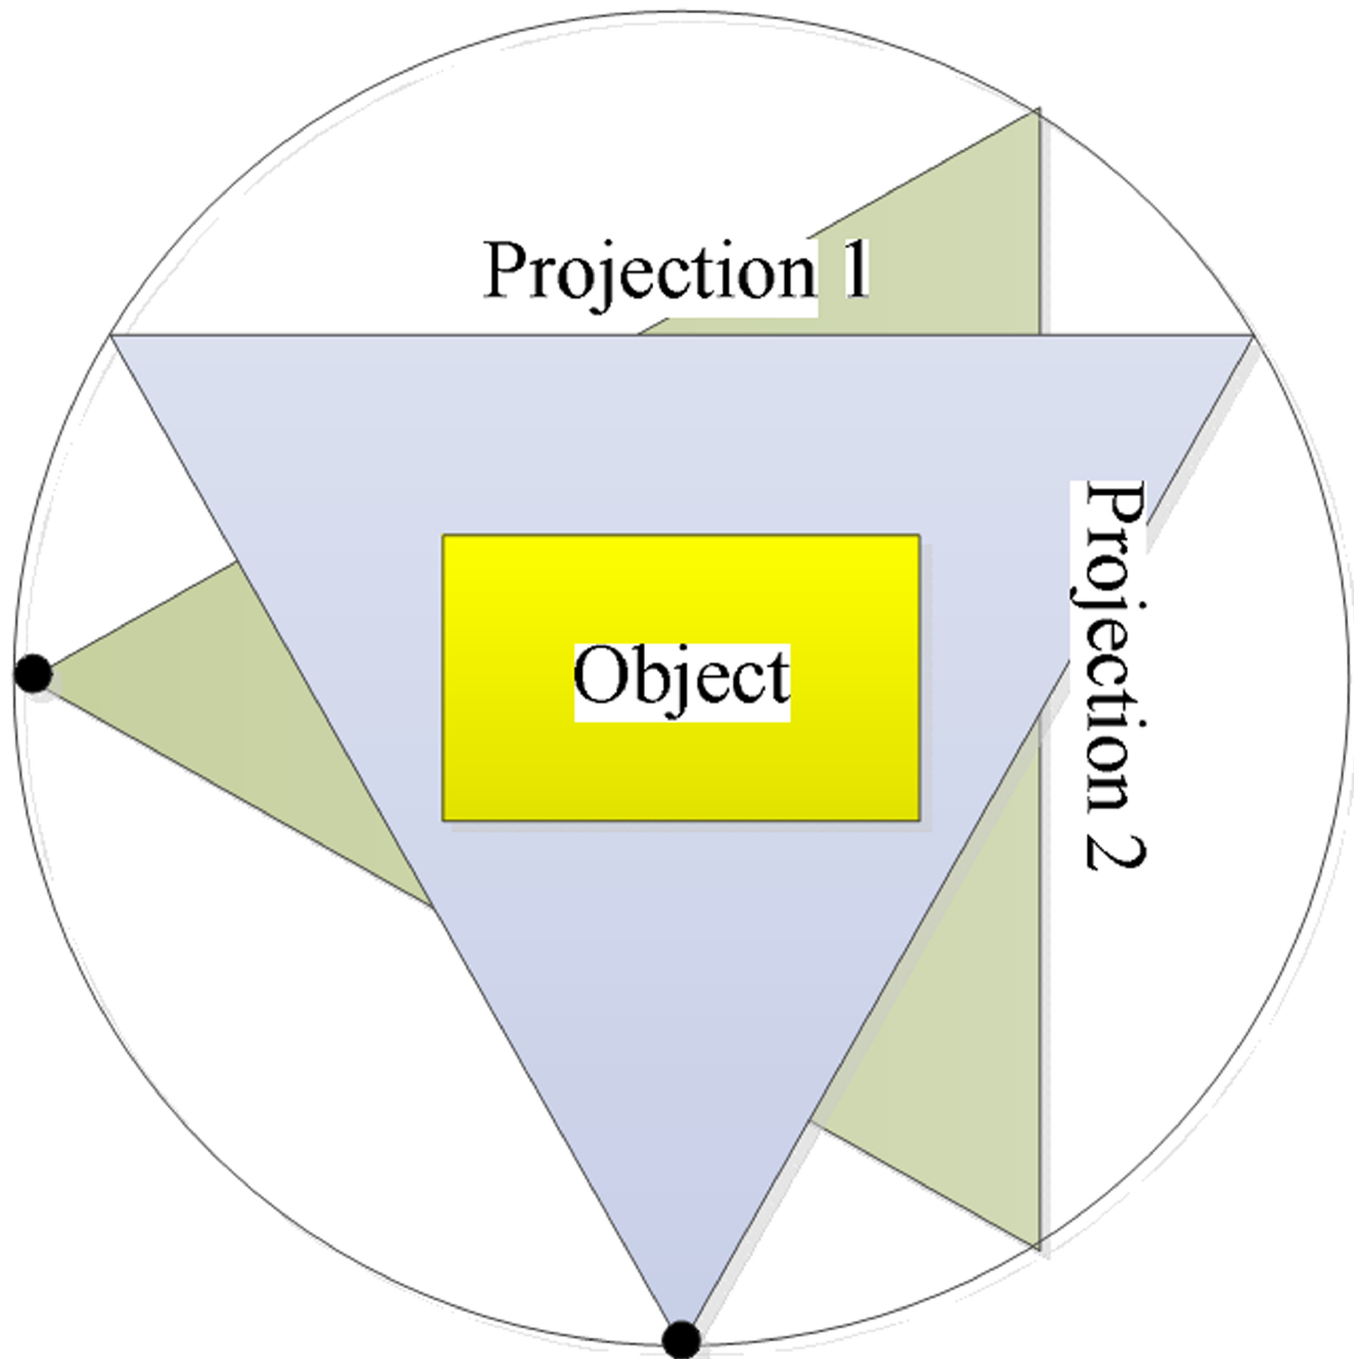
Fig 1. Circle trajectory scanning for a rectangular